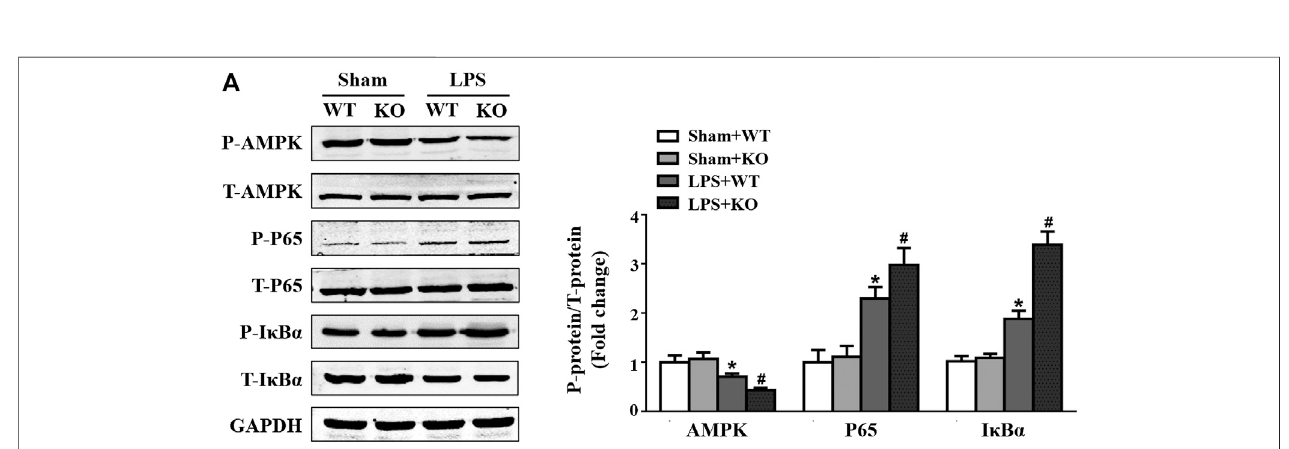
FIGURE7| Il12a deletion mediates macrophagepolarizationviatheAMPK/NF- κ Bpathway. (A) Western blotanalysisof p -AMPK,AMPK,p-p65, p65, p -I κ B α and I κ B α protein in each group (n (cid:1) 4). * p < 0.05 compared with the sham + WT group; # p < 0.05 compared with the LPS + WT group.